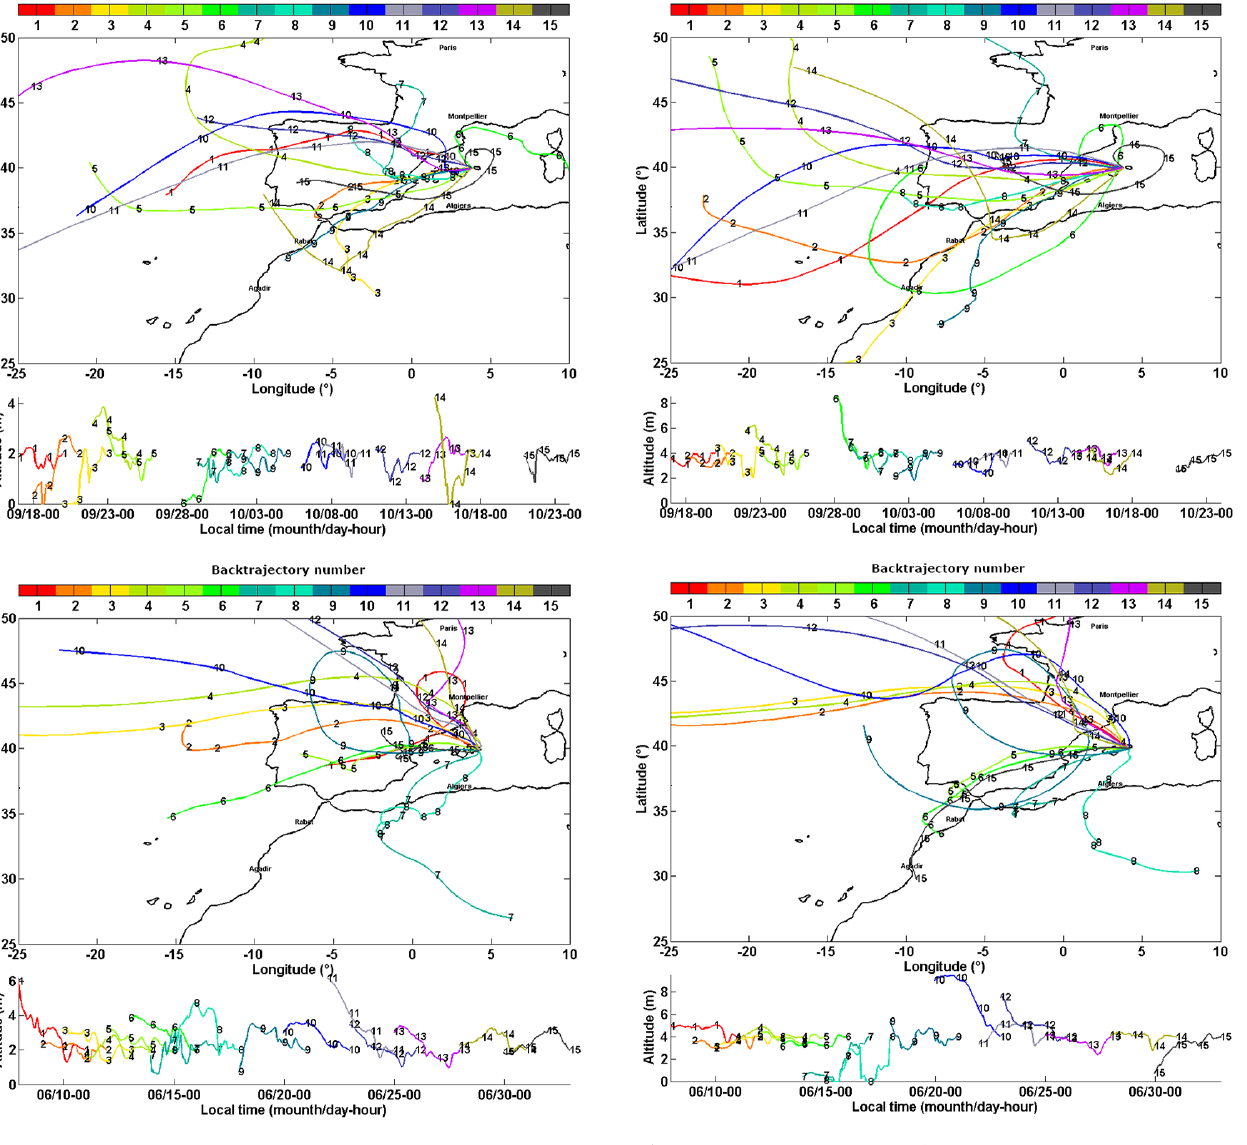
Figure 11. Same as Fig. 10 but for 2kma.m.s.l. Figure 12. Same as Fig. 10 but for